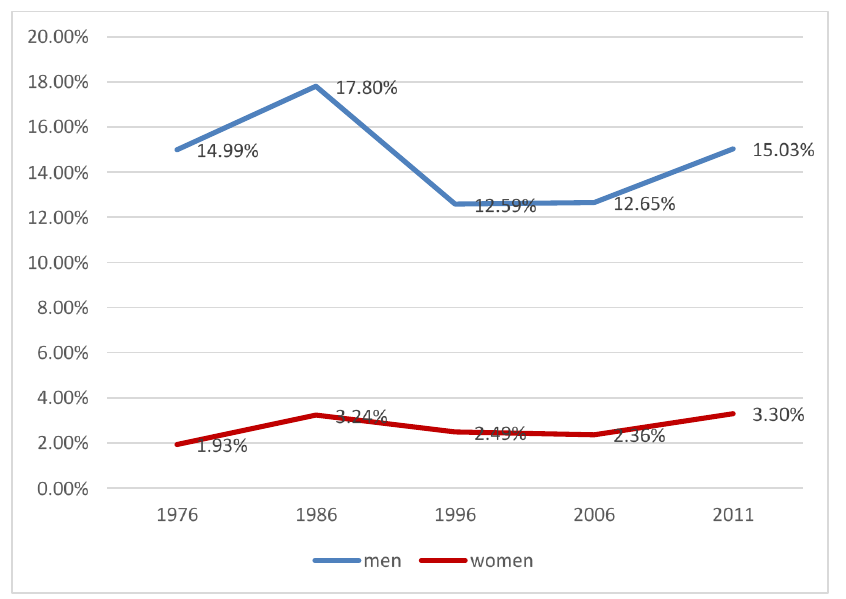
Figure 1. Percent of College Freshman Planning to Become